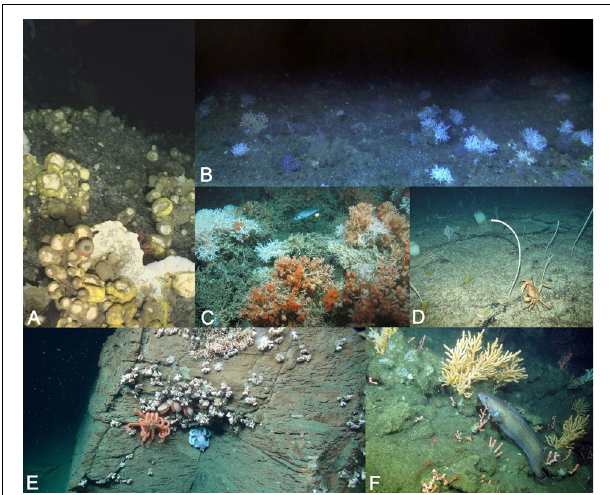
FIGURE 2 | Images showing the diversity of Vulnerable Marine Ecosystems, including cold-water coral reefs, coral gardens and sponge grounds, at different locations across the North Atlantic Ocean. (A) Astrophorid sponge ground typical of the Davis Strait area (2500 m), credit: Department of Fisheries and Oceans, Canada. (B) Cold-water coral reef dominated by Madrepora oculata , with scarce colonies of Lophelia pertusa and black corals ( Antipathes dichotoma ) at Gazul mud volcano (380 m, northern Gulf of Cadiz), credit: Instituto Español de Oceanografía, INDEMARES project. (C) Lophelia pertusa reef from Logachev Mounds (600 m, Rockall Bank), credit: J.M. Roberts, University of Edinburgh (Changing Oceans Expedition 2012, RRS James Cook cruise 073). (D) Coral garden formed mainly by Narella versluysi and N. bellisima with some Hexactinellid sponges (1000 m) in the